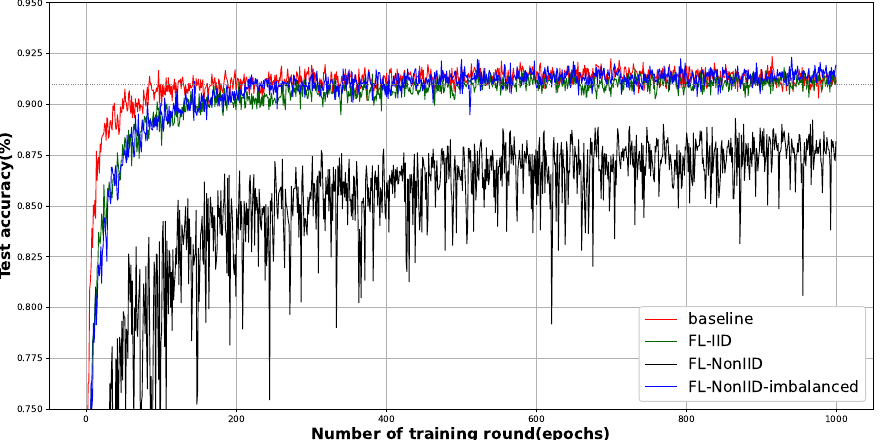
Figure 3. The figure shows the test accuracy of four schemes, i.e., the centralized CNN-based deep learning model (baseline) and the CNN-based deep learning model with FL on three data distributions—IID, non-IID, and non-IID imbalanced. Training rounds ran up to 1000 epochs. The horizontal gray dotted line indicates